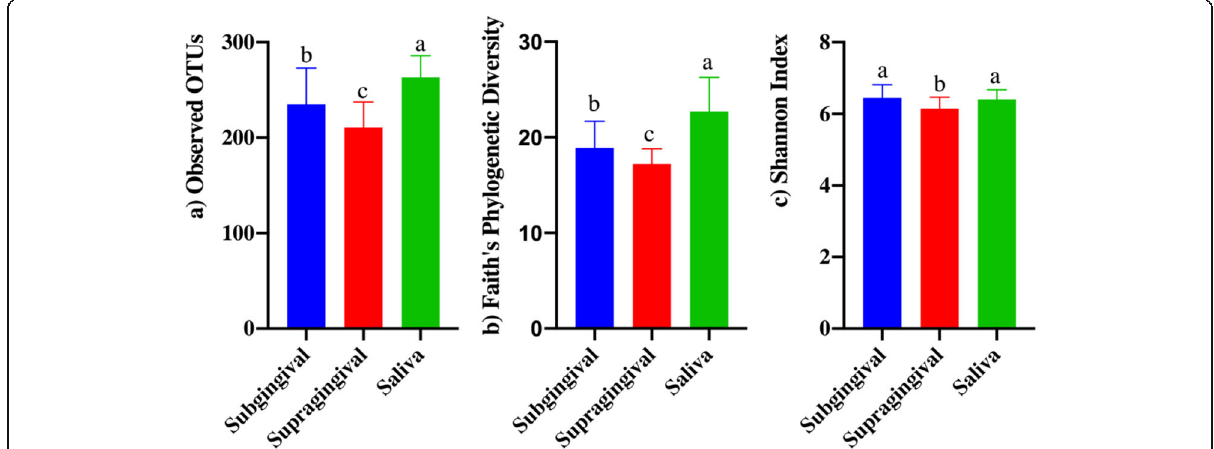
Fig. 1 Bacterial alpha diversity indices of canine salivary and plaque samples as assessed by the observed operational taxonomic units (OTU) ( a ), Faith ’ s Phylogenetic Diversity ( b ), and Shannon Index ( c ). Groups with different superscripts differ ( p <0.001)